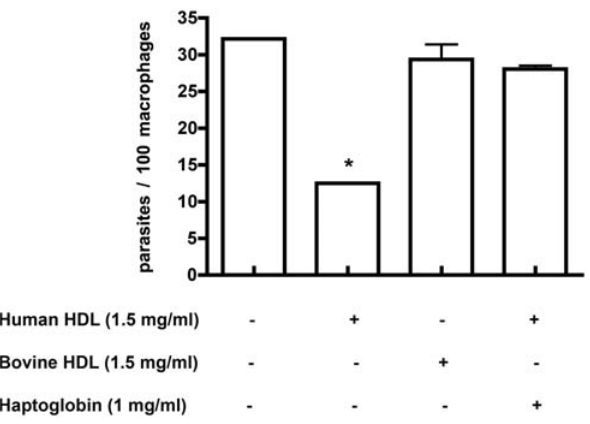
Figure 9. Haptoglobin inhibits lytic HDL killing of L.major in macrophages. BALB/c bone-marrow derived macrophages were infected with L. major promastigote metacyclics at a multiplicity of infection of 3:1, for 2 hours before the addition of human or bovine HDL (1.5 mg/ml) in the presence or absence of Hp (1 mg/ml) for 24 hours. The data represent the mean 6 SD of duplicate cultures of one typical experiment that has been repeated twice. * p , 0.05 compared to bovine HDL, ANOVA test.